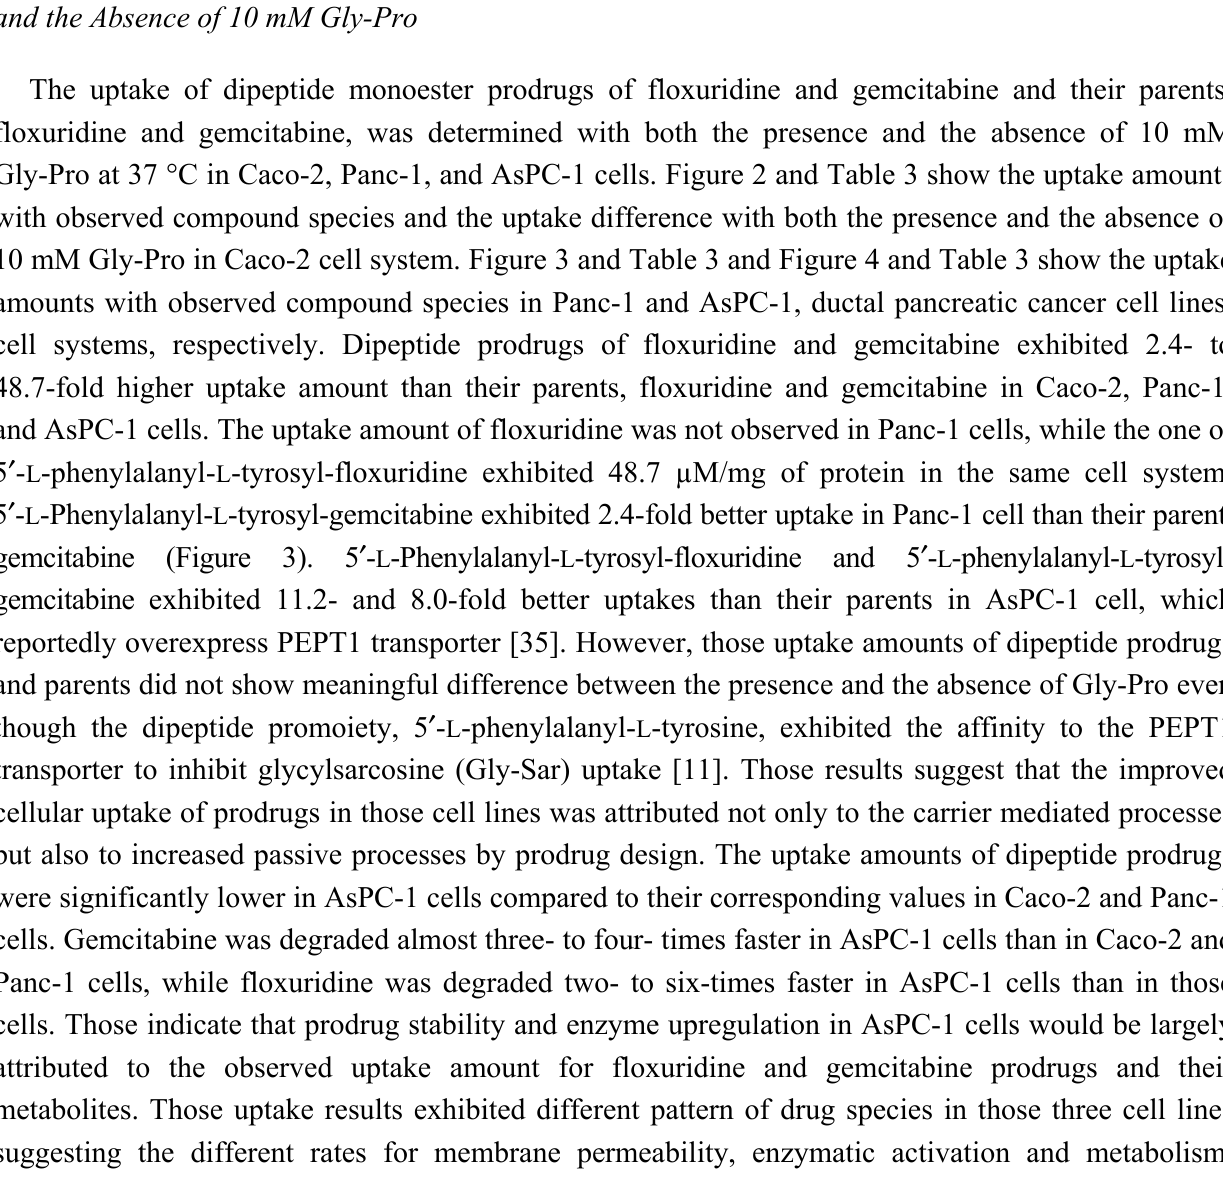
Table 2. Stability of floxuridine, floxuridine prodrug, gemcitabine and gemcitabine prodrugs in 0.01N HCl, SIF (pH 6.0), pH 7.4 Buffer and biological media (mean ± SD, n = 3). 0.01 N SIF pH 6.0 Prodrug HCl t (min) 1/2 Gemcitabine >120 >120 >120 tyrosyl-gemcitabine Floxuridine >120 tyrosyl-floxuridine